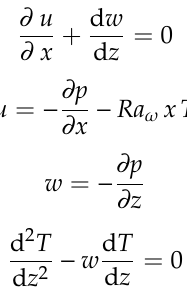
The convection in the core region far from the sidewalls was the objective of the investigation.